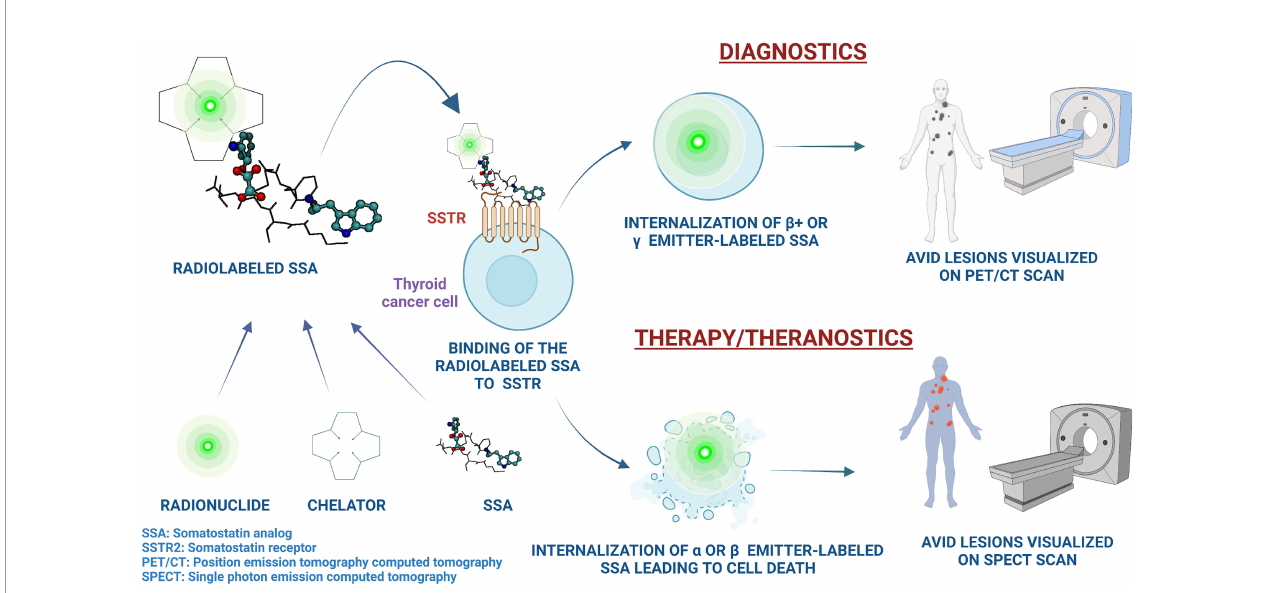
FIGURE 2 | An illustration of the principles of utility of radiolabeled somatostatin analogs in the management of thyroid cancer, along with the mechanisms of action and the theranostic properties of peptide receptor radionuclide therapy. Image created on